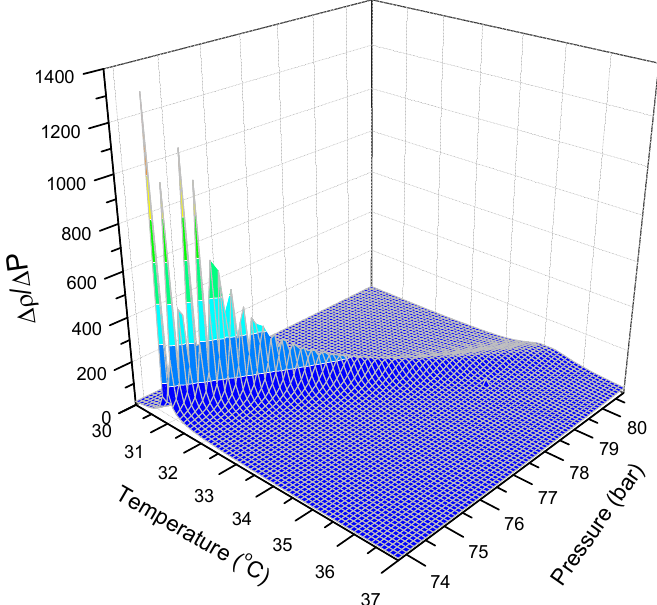
Figure 10. Density gradient of CO 2 with respect to pressure.